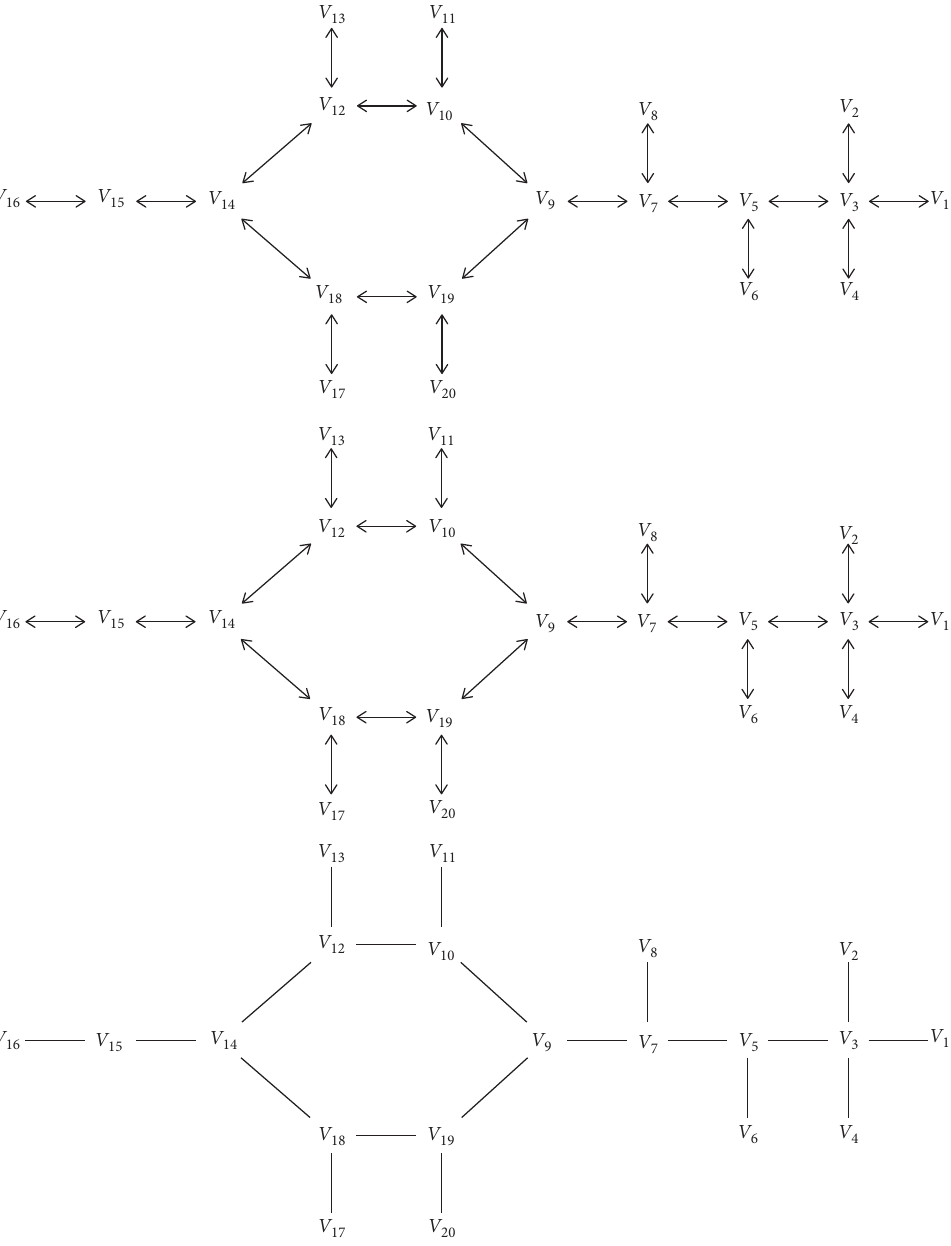
Scheme 1: The graph of